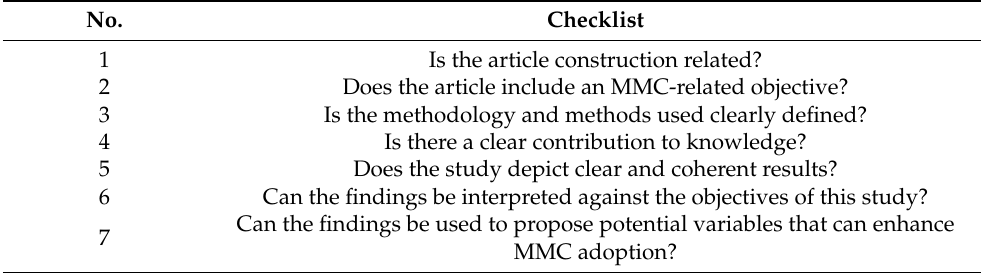
Table 2. Inclusion–exclusion criteria of relevancy.